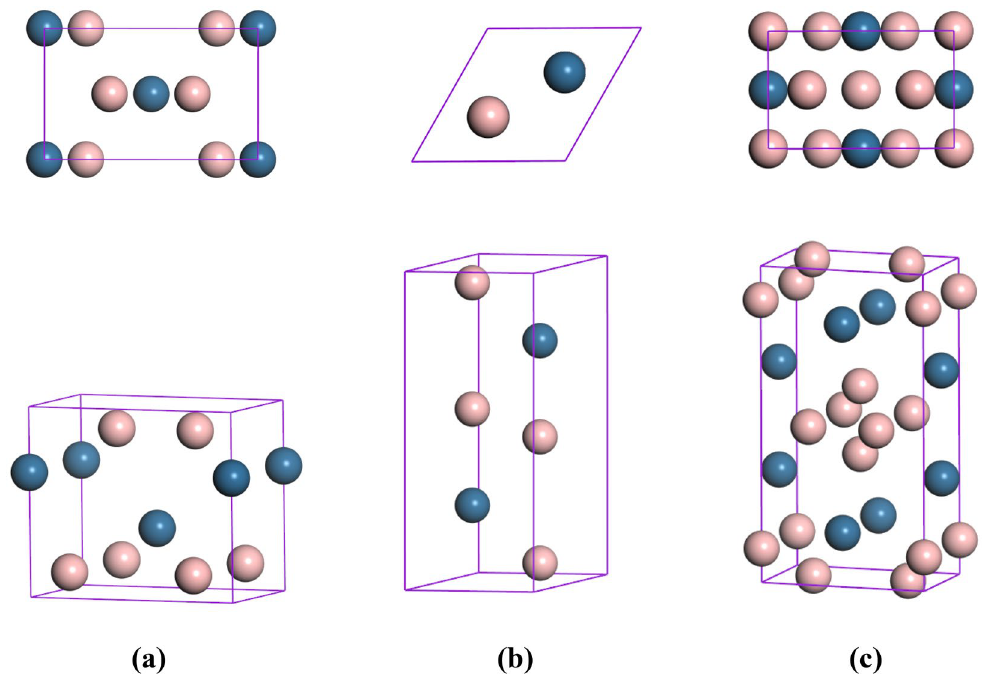
Figure 1. Top and three-dimensional views of the predicted crystal structures. ( a ) oP 6-OsB 2 at 0 GPa, ( b ) hP 6- OsB 2 at 20 GPa, and ( c ) oI 12-OsB 2 at 400